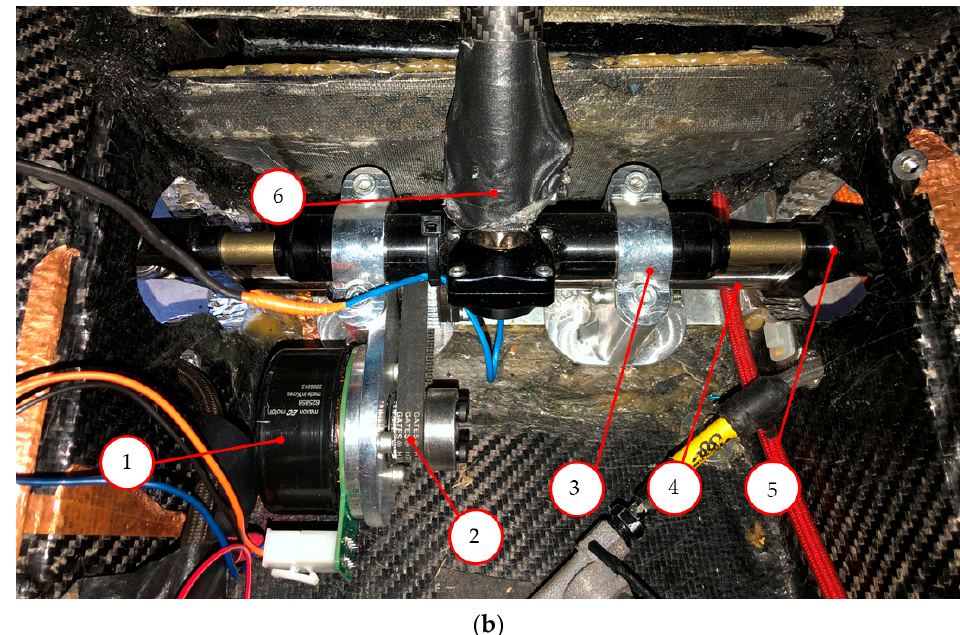
Figure 2. ( a ) Autonomous EPS system positioning in the vehicle CAD model. ( b ) EPS positioning in